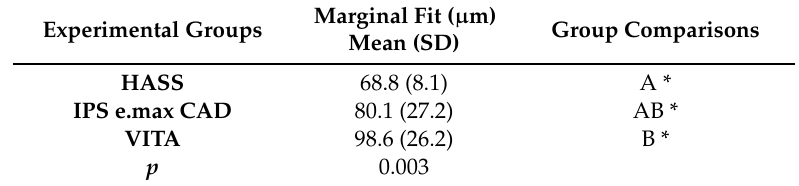
Table 4. Comparison of the marginal fit according to the type of lithium disilicate block.